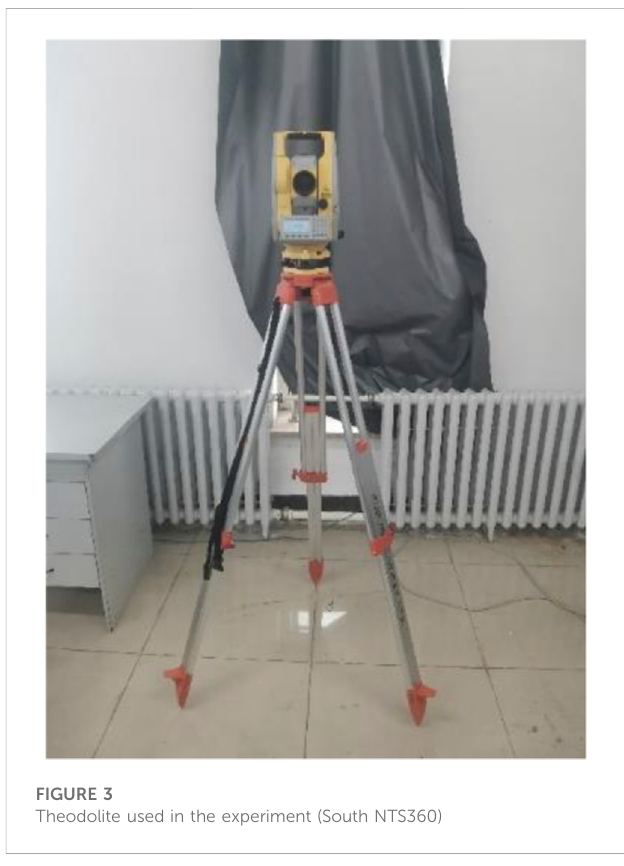
FIGURE 3 Theodolite used in the experiment (South